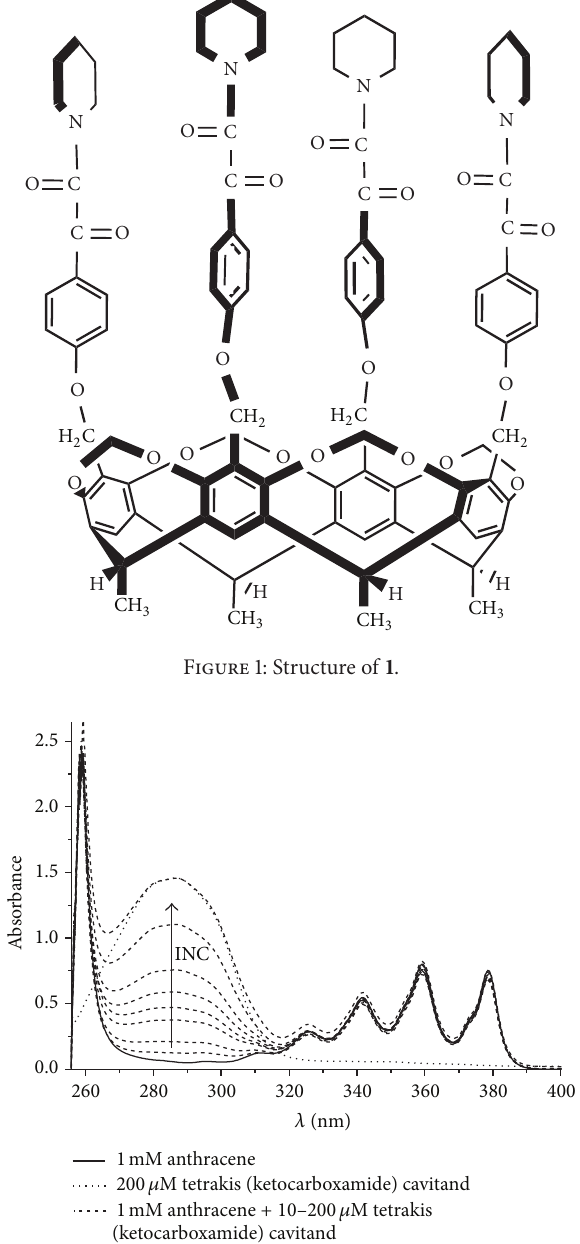
Figure 2: Absorption spectrum of anthracene (1mM), 1 (200 𝜇 M) and anthracene in the presence of different concentrations of 1 (the arrow indicates increasing concentration of 1